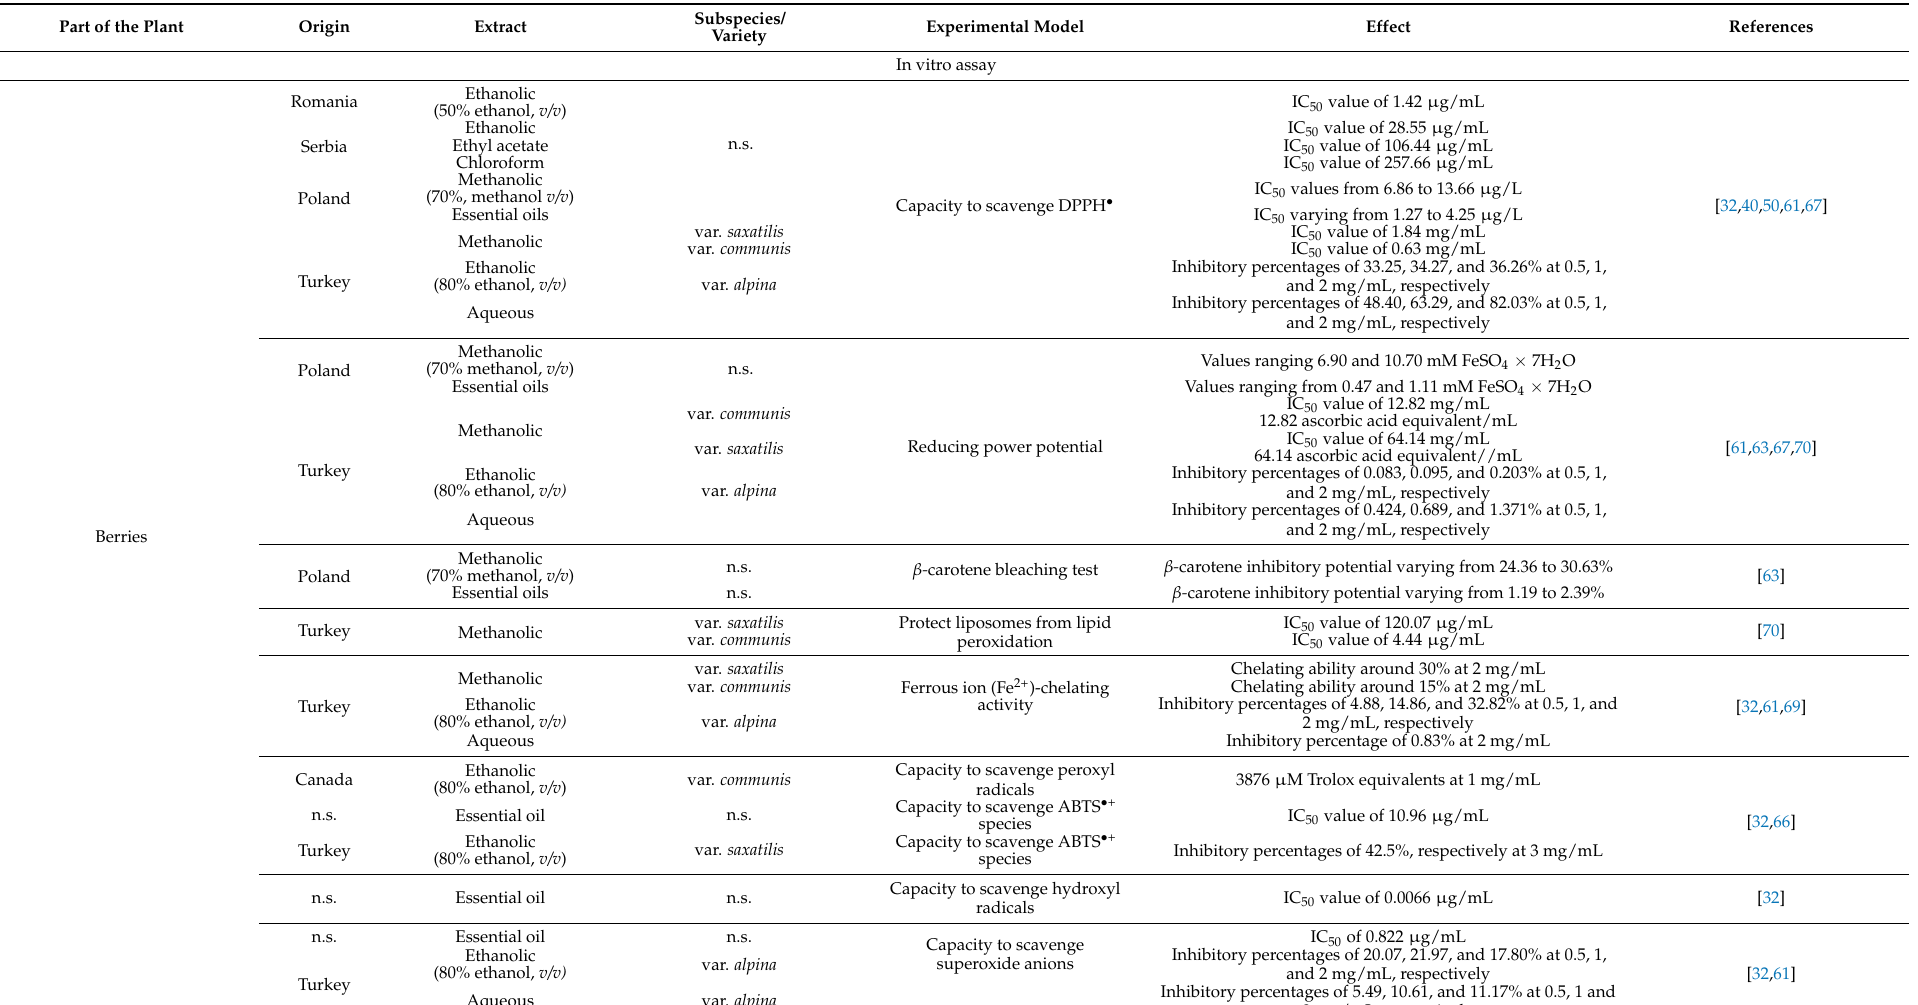
Table 3. In vitro and in vivo antioxidant effects of Juniperus communis